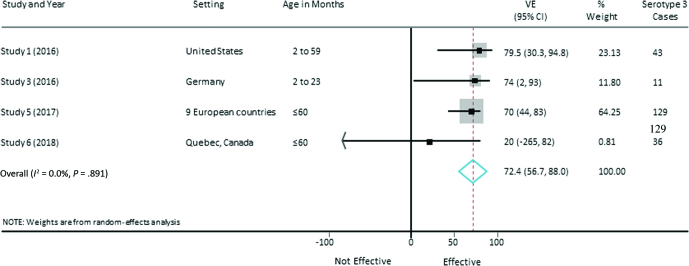
Vaccine effectiveness for at least 1 dose of 13-valent pneumococcal conjugate vaccine against serotype 3 invasive pneumococcal disease including published and unpublished studies with nonoverlapping datasets. Abbreviations: CI, confidence interval; VE, vaccine effectiveness.